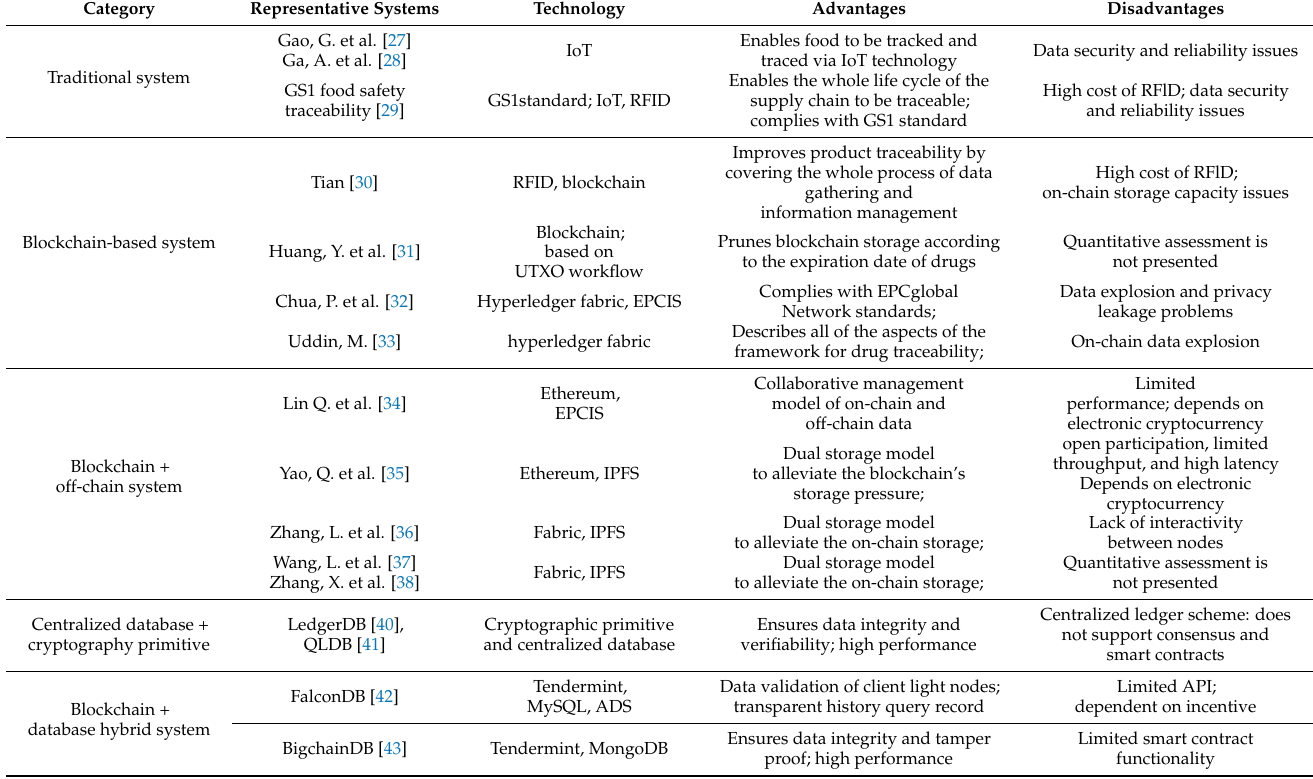
Table 1. Analysis of the existing works in the